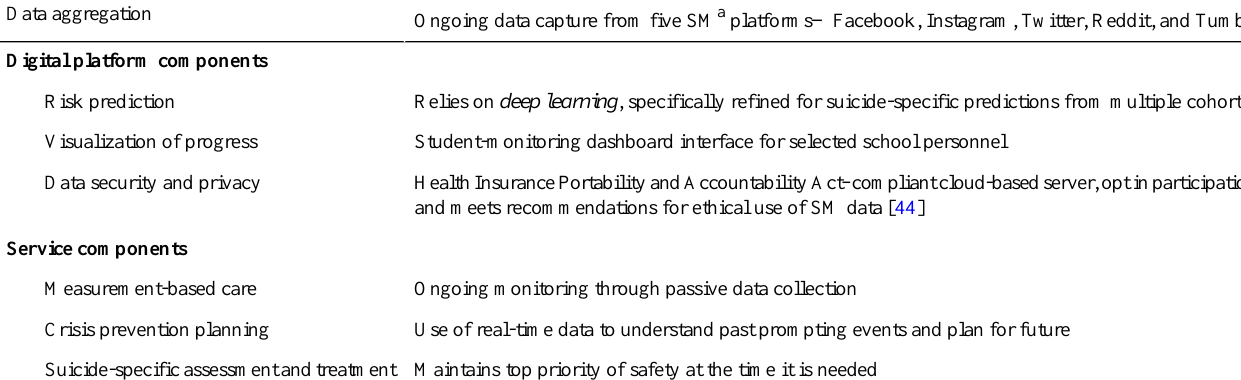
Ongoing data capture from five SM a platforms—Facebook, Instagram, Twitter, Reddit, and TumblrData aggregation